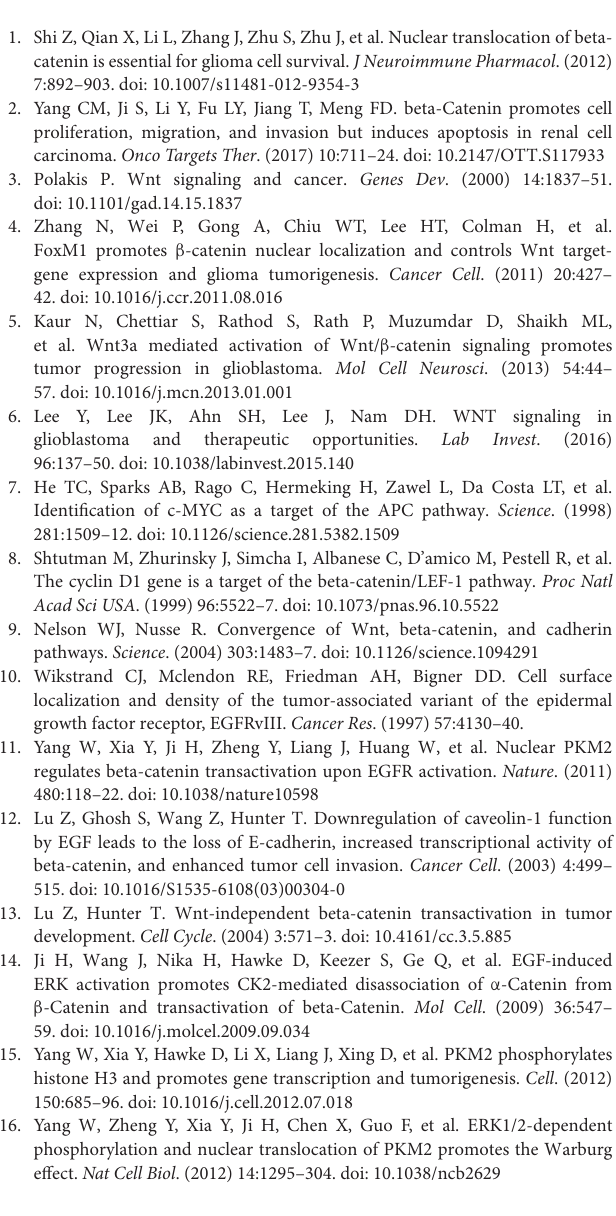
EGF for 12h. The mRNA expression levels (D) and the protein expression levels (E) of CCND1 and MYC in LN229 and A549 cells were determined by real-time PCR and immunoblotting analyses with the indicated antibodies, respectively. Data represent the means ± SD of three independent experiments. ∗ P < 0.001, based on the Student’s t -test.